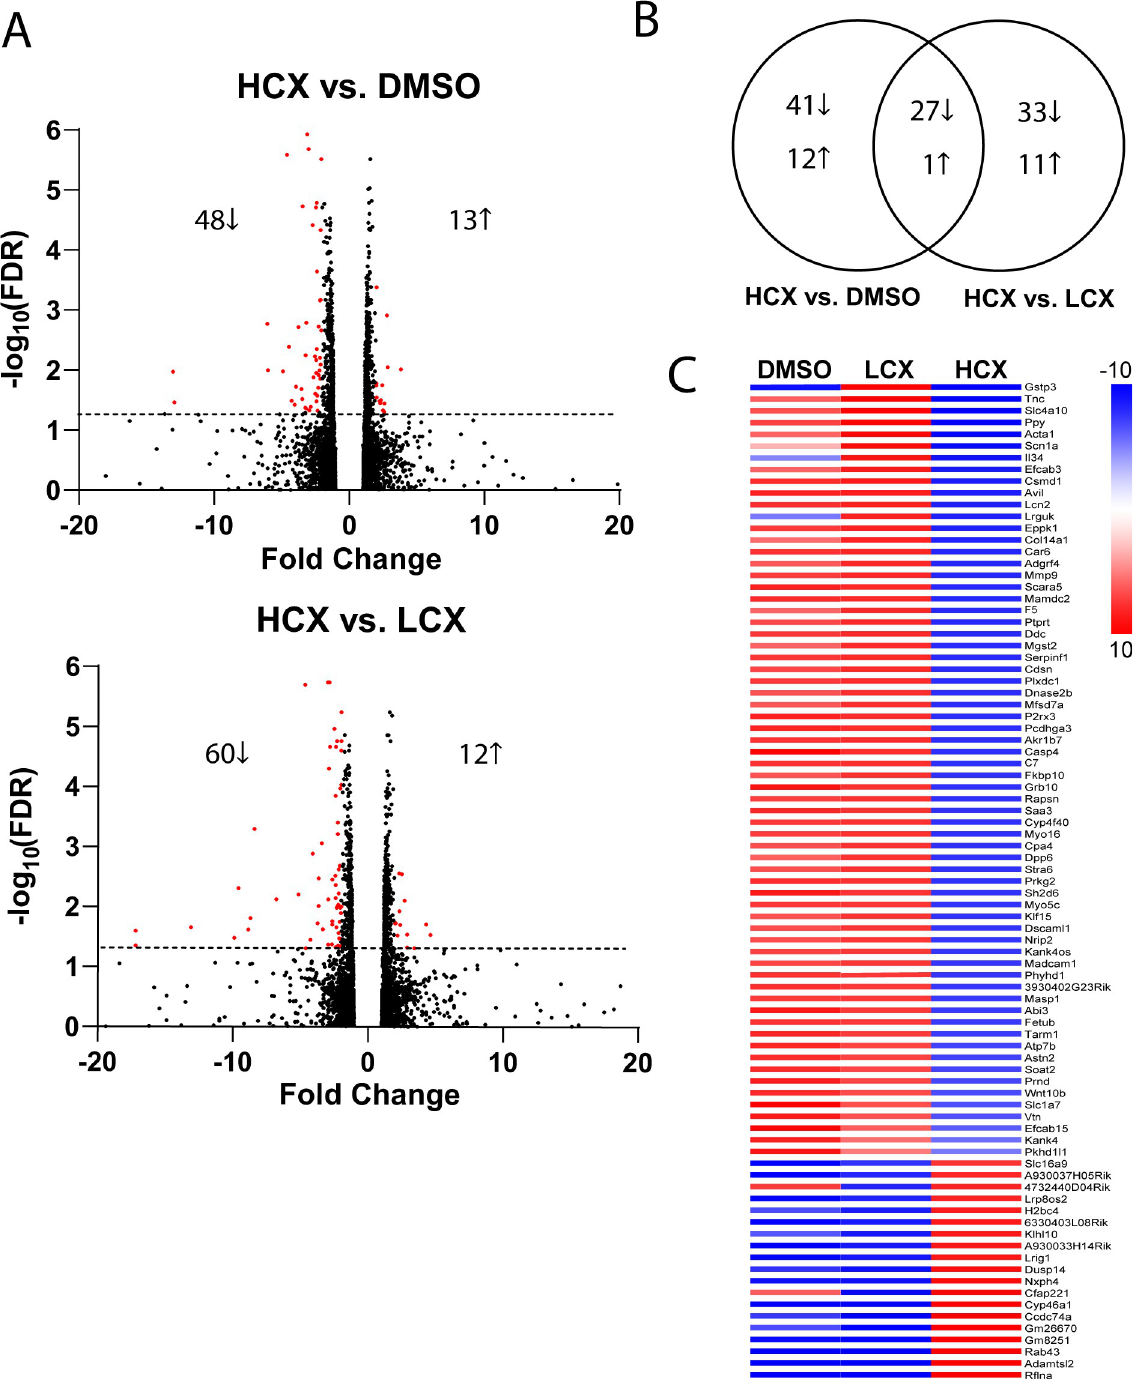
Fig 6. RNAseq analysis of xyloside-treated Neuro2a cells. Neuro2a cells were treated with the indicated levels of xylosides for 72h. RNA was extracted and sequenced. A) Volcano plots showing significant changes in gene expression ( > 50% change, P < 0.5) between HCX and DMSO- treated cells and HCX and LCX-treated cells. B) Venn diagram showing numbers of genes changed with HCX compared to DMSO and LCX treatment. C) Heat map of expressed genes that were changed by xyloside treatment. Color represents deviation from the average expression over all